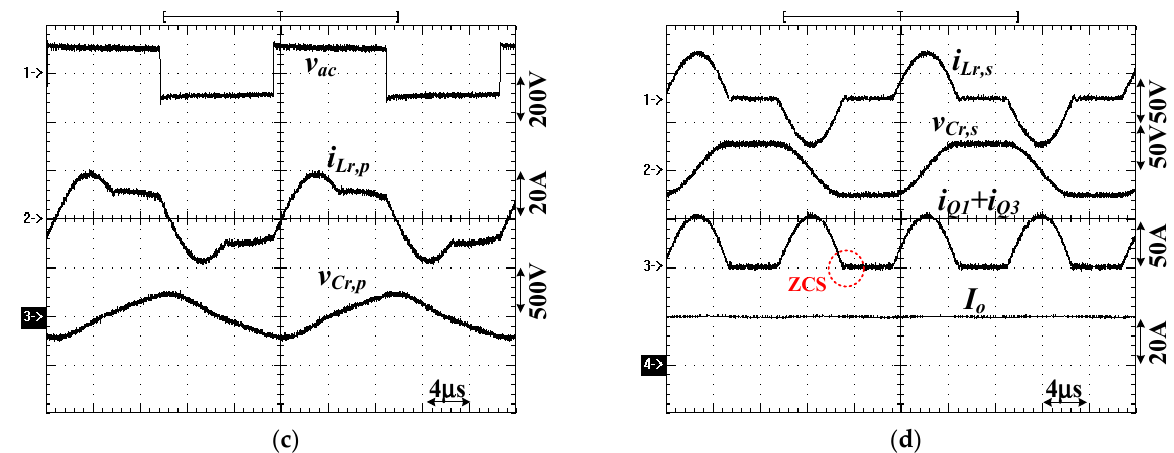
Figure 13. Measured waveforms of the proposed converter operated at forward power flow and V in = 198 V: ( a ) S 1 , S 2 and S 5 signals at 20% load power, ( b ) S 1 , S 2 and S 5 signals at 100% load power, ( c ) v ac , i Lr,p and v Cr,p at full rated power, ( d ) i Lr,s , v Cr,s , i Q 1 + i Q 3 and I o at full rated power.